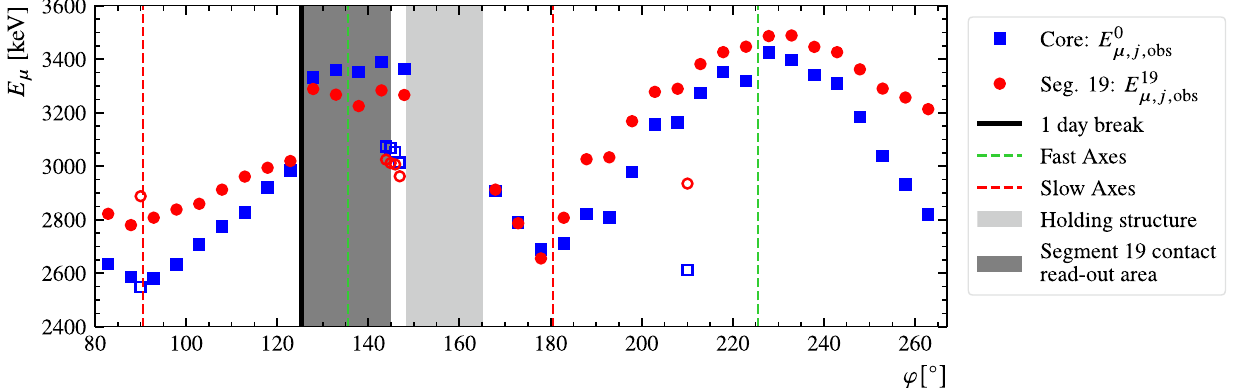
ϕ . Only between the two measurements next to the vertical solid black Fig. 15 The fitted E 0 μ, and E 19 μ, of the measurements from j , obs j , obs line, there was a larger time difference of approximately one day. Data AST at r = 23 . 8mm. Error bars indicating uncertainties would be hid- points taken four months later are shown with open den by the markers. The data points shown with solid markers were taken directly after each other starting from lower to higher values of